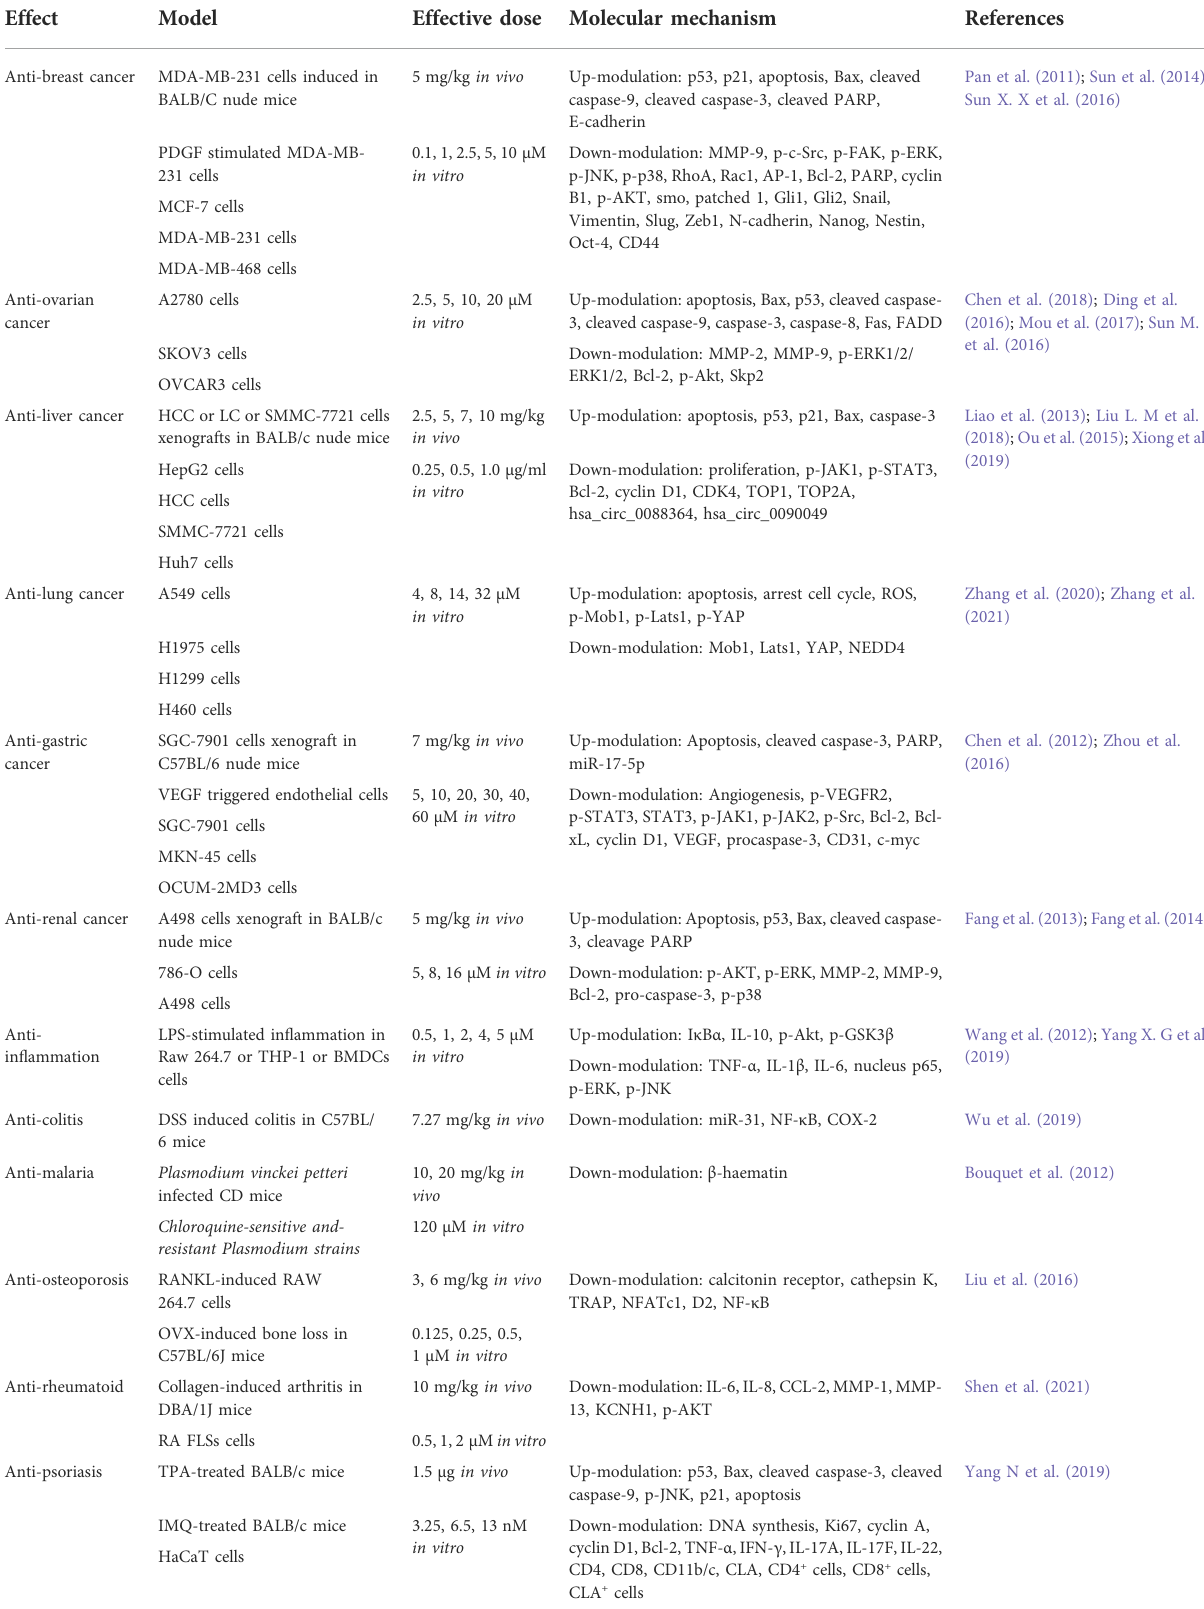
TABLE 1 Main activities of nitidine chloride and the underlying action